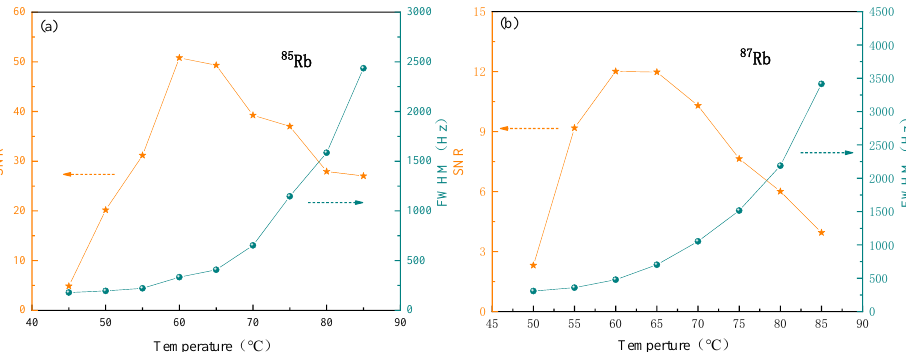
Figure 4. Effect of different atomic number densities on FWHM and SNR after FFT of 85 Rb atomic ensemble ( a ) and 87 Rb atomic ensemble ( b ).